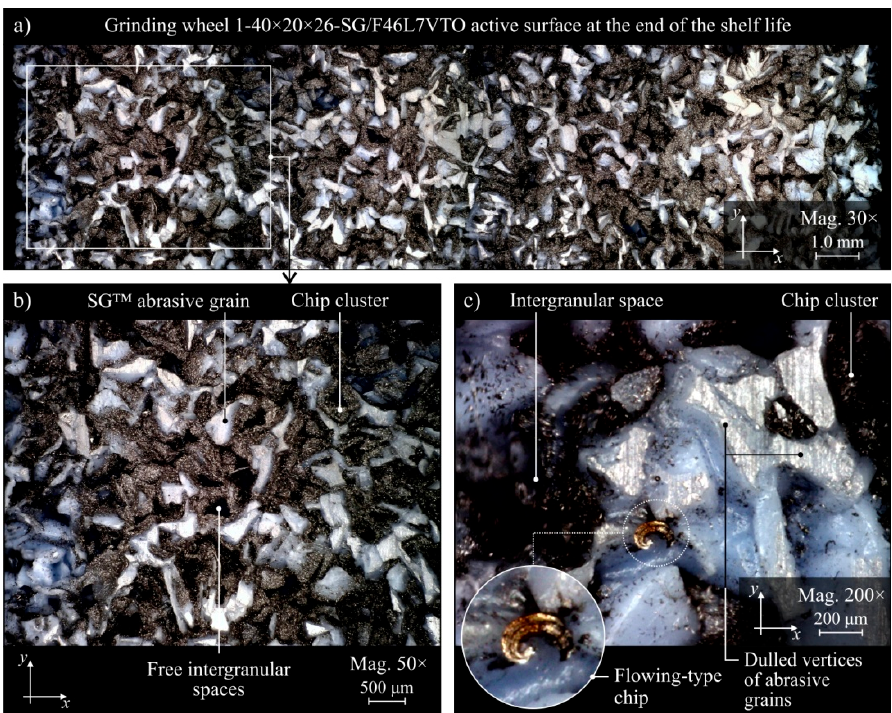
Figure 17. Microscope images of the GWAS after machining using the flood method of cooling and lubrication, recorded with the Dino-Lite Edge AM6715MZT digital measuring microscope: ( a ) magnification 30×; ( b ) magnification 50×; ( c ) m magnification 200×.